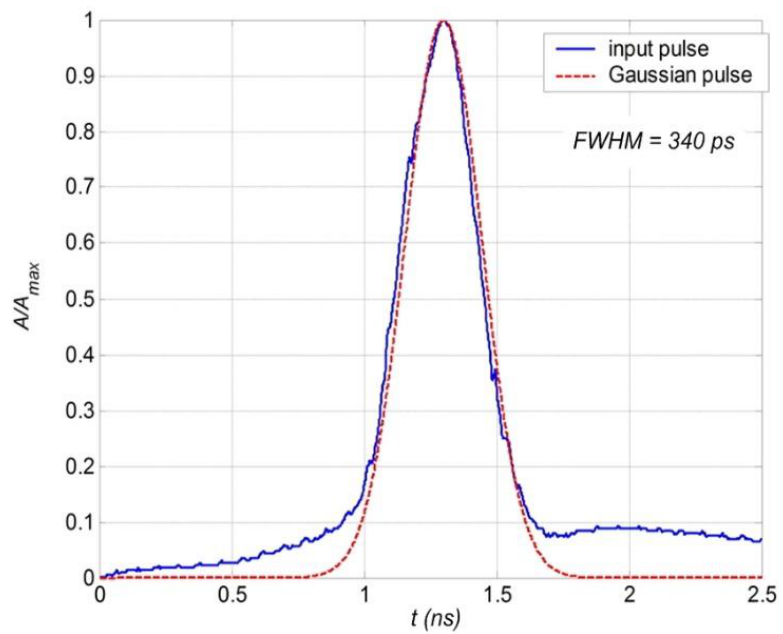
Figure 15. Reference optical pulse.